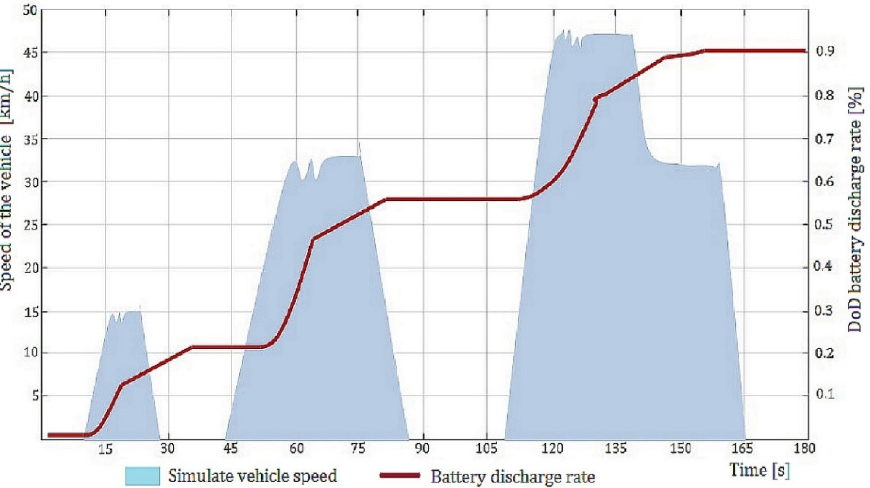
Figure 13. Plot of the battery discharge rate and speed of an electric car for a multi-valued logic tree with the floor layout of decision variables of: X 5 , X 4 , X 1 , X 2 , X 3 .